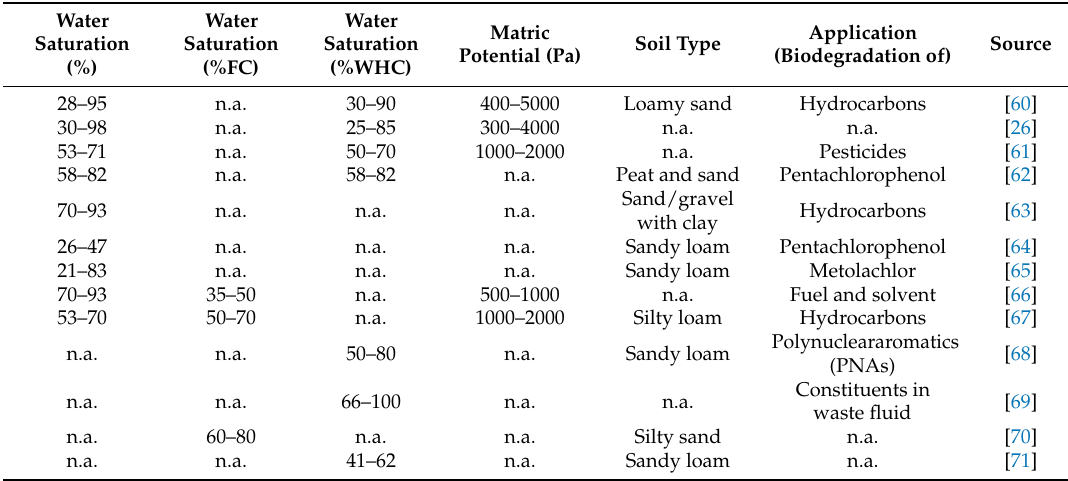
Table 4. Water saturation and matric potential ranges for optimal biodegradation conditions.